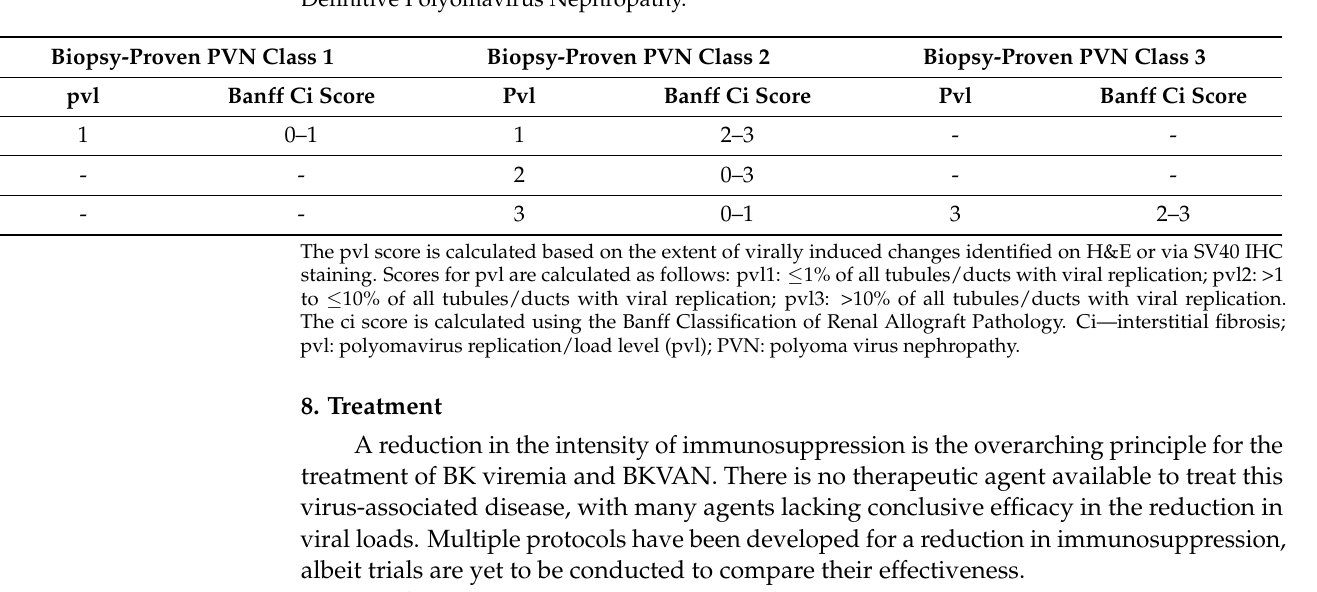
Figure 6. In situ hybridization for BK virus RNA (600×). Table 1. Histologic classification system of PVN for the Banff Working Group Classification of Definitive Polyomavirus